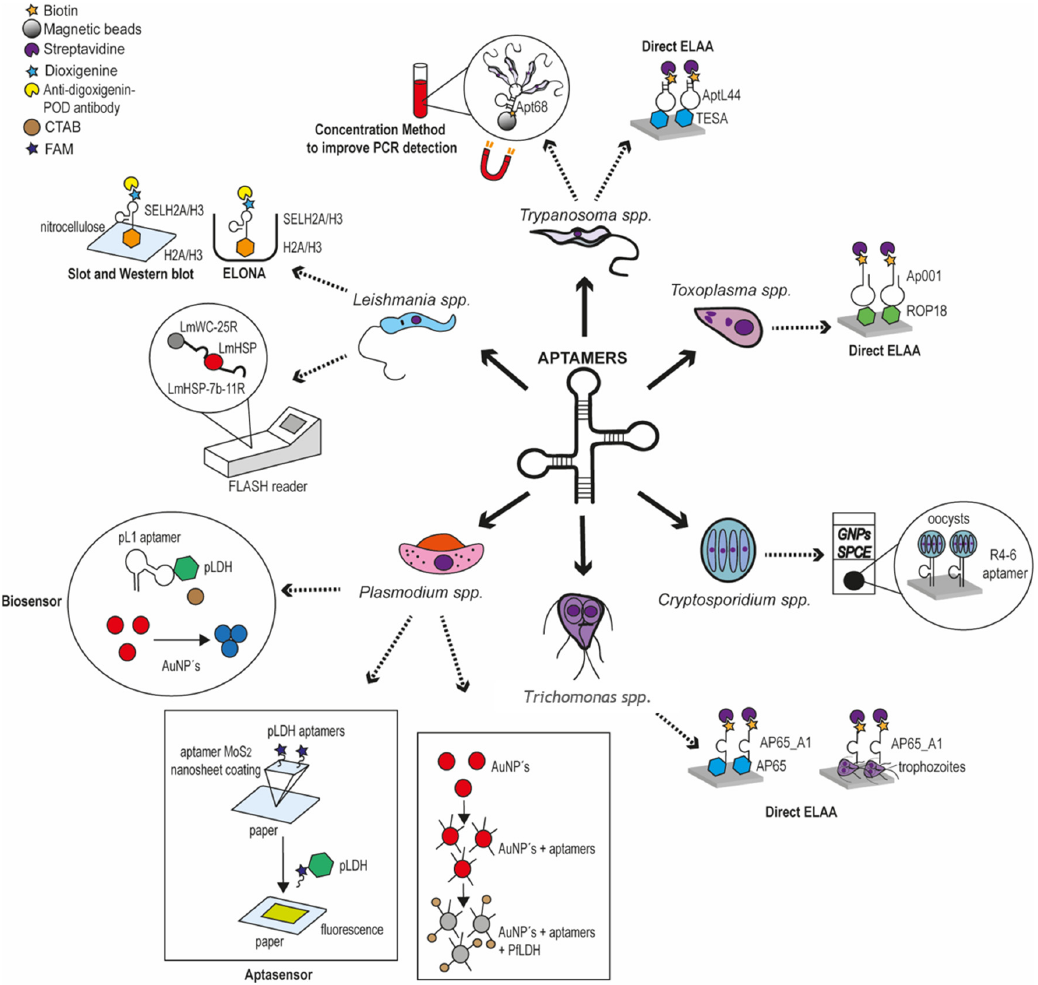
Figure 2. Summary of the main diagnostic tests based on aptamers to identify parasite infections produced by Plasmodium , Leishmania , Trypanosoma , Cryptosporidium , Toxoplasma and Trichomonas .